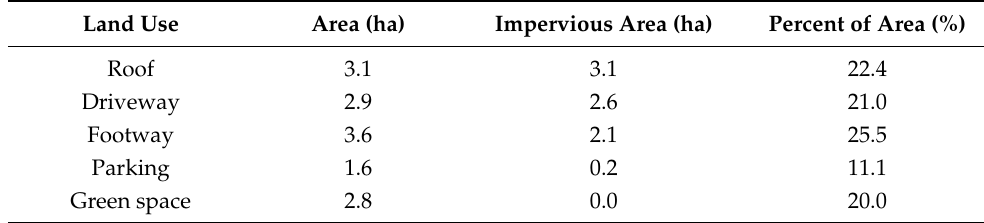
Table 1. Extent of land use types within the Tai Hung Tulip House (THTH) community. Land